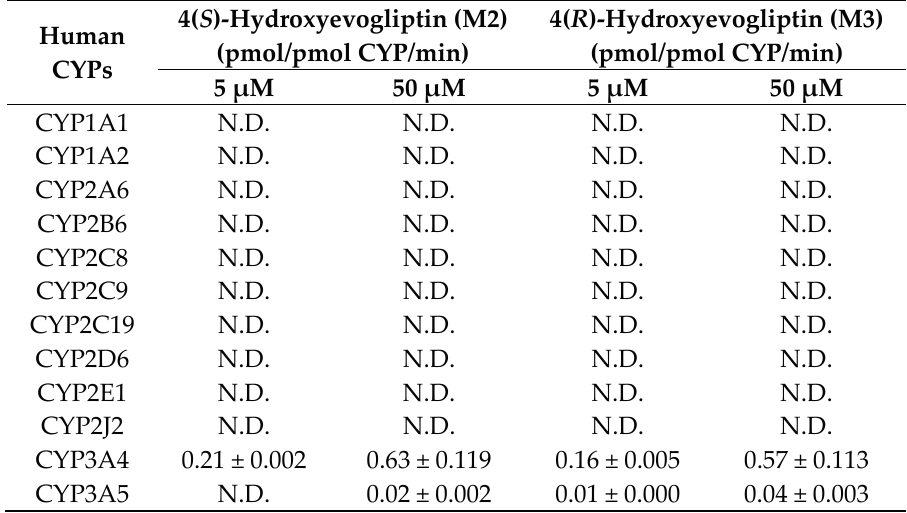
Table 2. Formation rates of 4( S )-hydroxyevogliptin (M2) and 4( R )-hydroxyevogliptin (M3) from 5 and